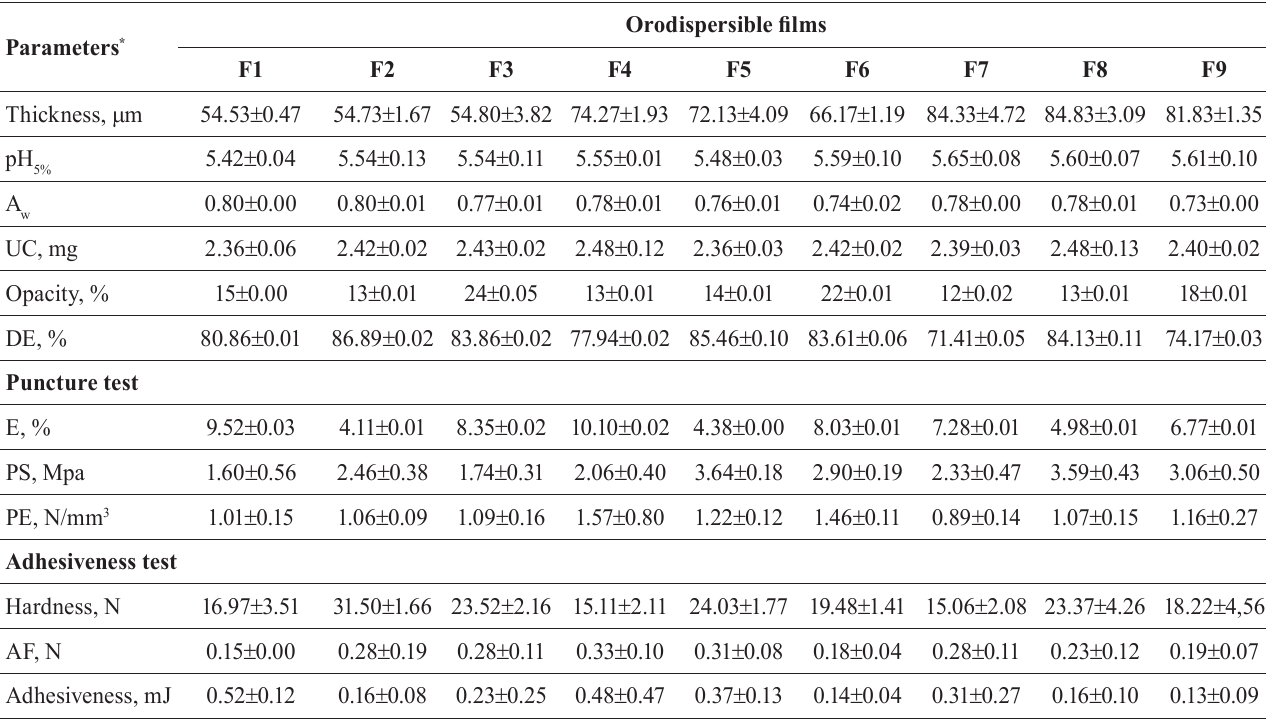
TABLE III - Average values (n = 3) of the physicochemical and mechanical properties of orodispersible films